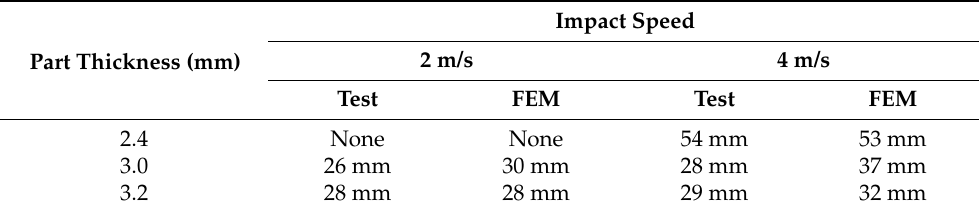
Table 4. Impactor displacement (mm) at the moment of part fracture from experimental tests (Column “Test”) and from Finite Element Model (Column